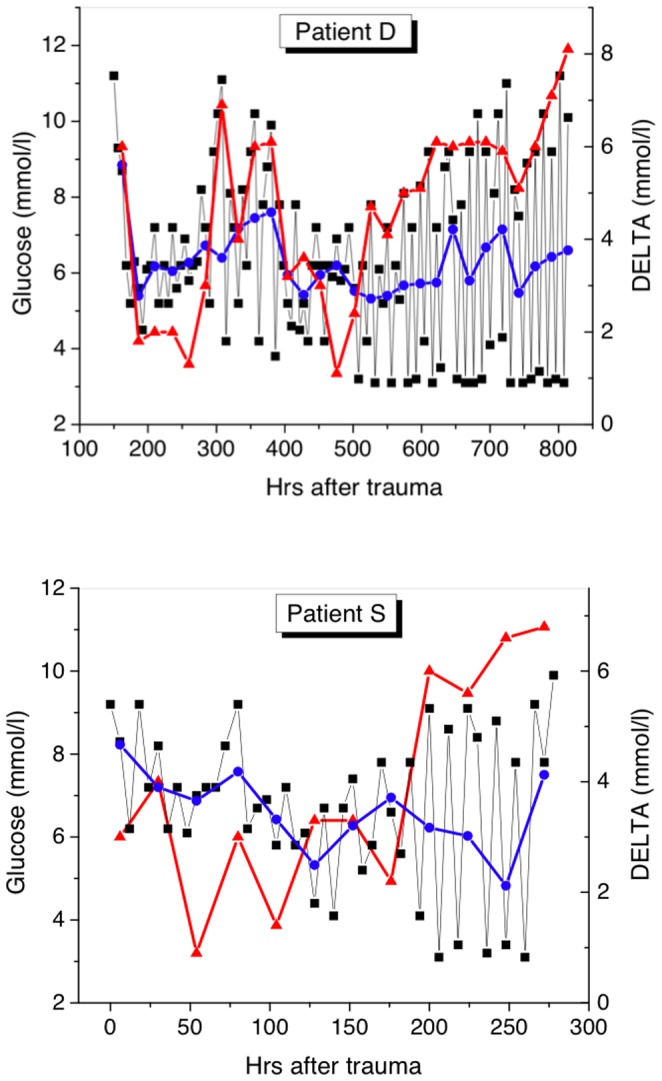
Time series of glucose measurements for patients from Group 3 (non-survivors).DELTA increases drastically before death, while the mean daily glucose remains within an acceptable range.